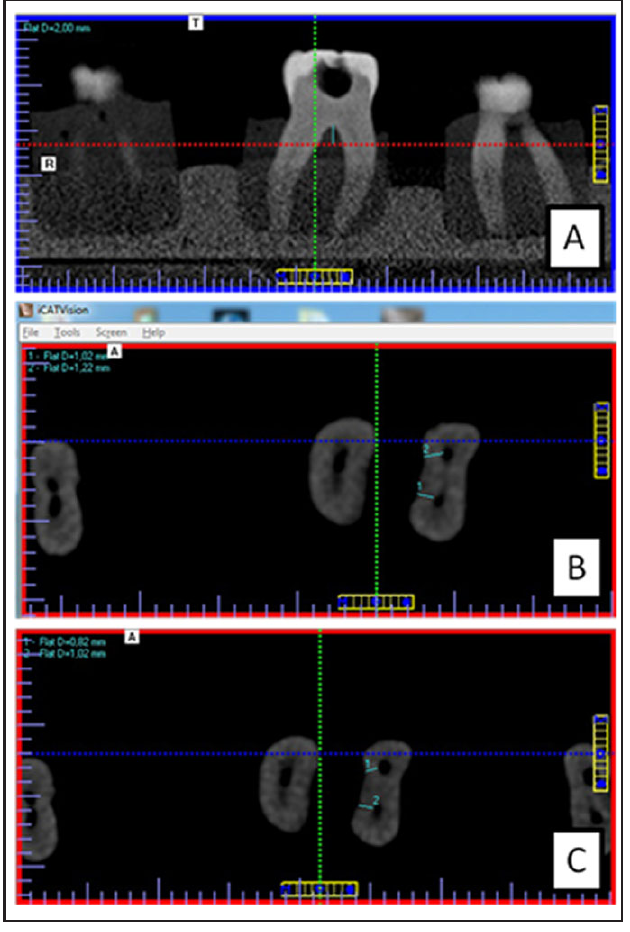
Fig. 2. Data acquisition and processing: A) Measurement from the highest point of the furcation area to 2 mm apically; B) Measurement of the risk zone before cervical preparation; C) Measurement of the risk zone after cervical preparation.